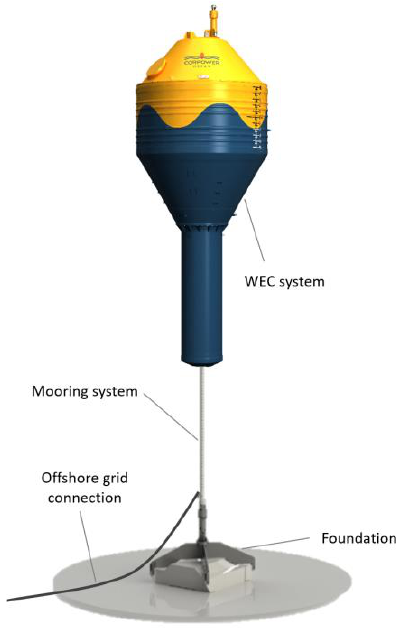
Fig. 7. CorPower’s WEC concept.